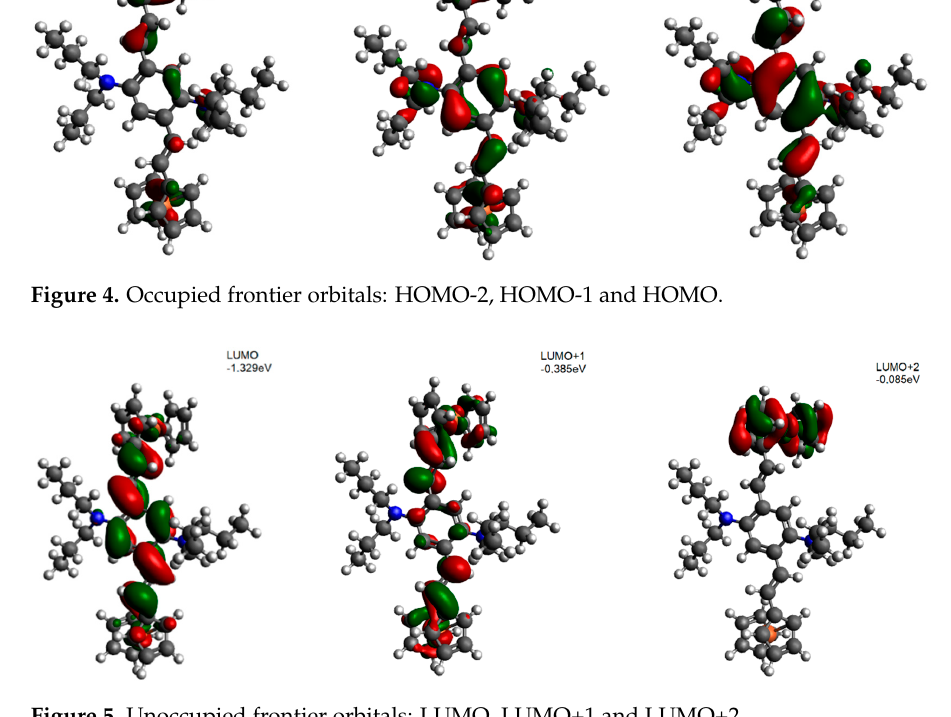
Figure 5. Unoccupied frontier orbitals: LUMO, LUMO+1 and LUMO+2.